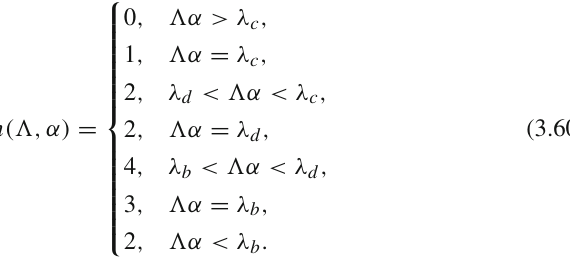
< λ = λ d c b and hence